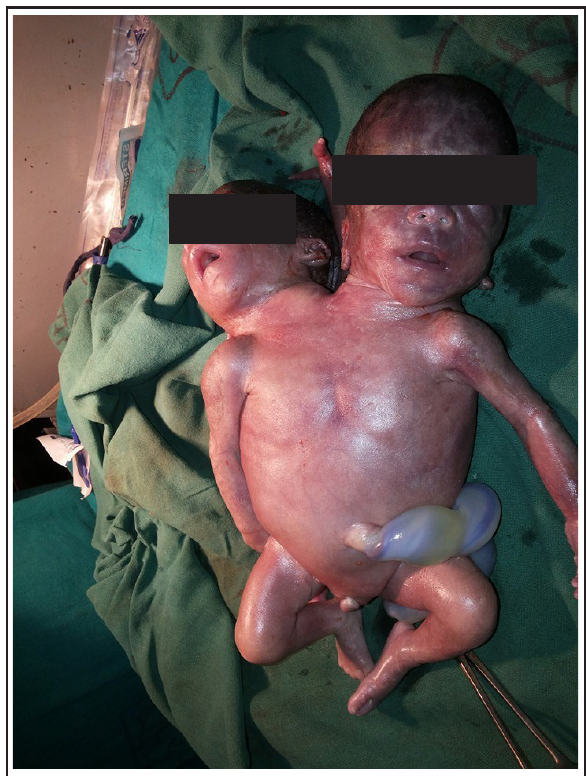
Figure 2. Conjoined